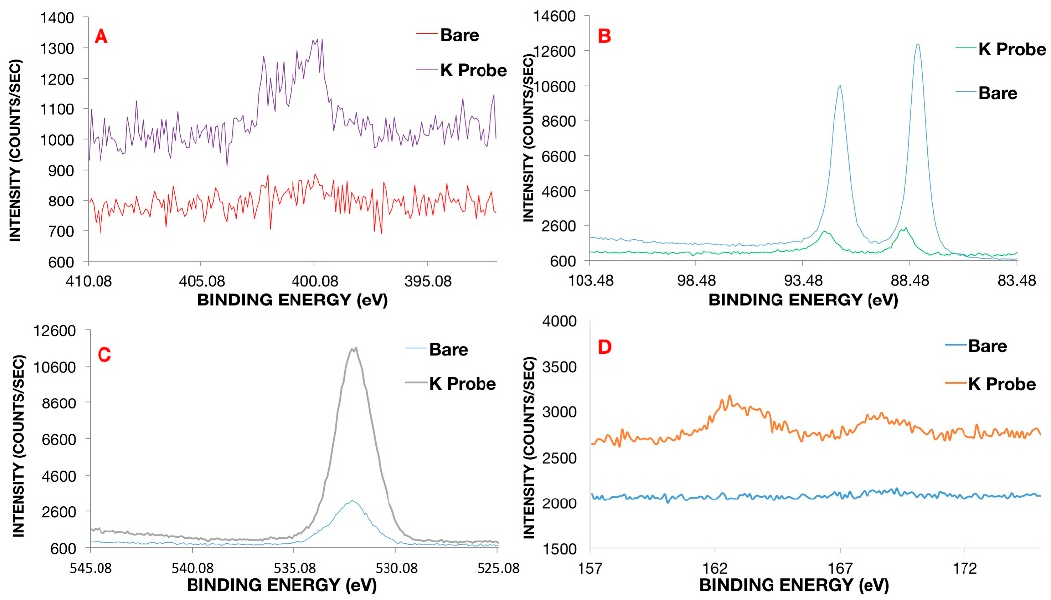
Figure 2. X-ray Photoelectron Spectroscopy (XPS) narrow scans on gold microelectrode for: ( A ) nitrogen; ( B ) gold; ( C ) oxygen and ( D ) sulfur, respectively. Bare cleaned gold was compared to gold coated with a mixed monolayer of K + probe and MEG-SH in a 1:10 ratio.